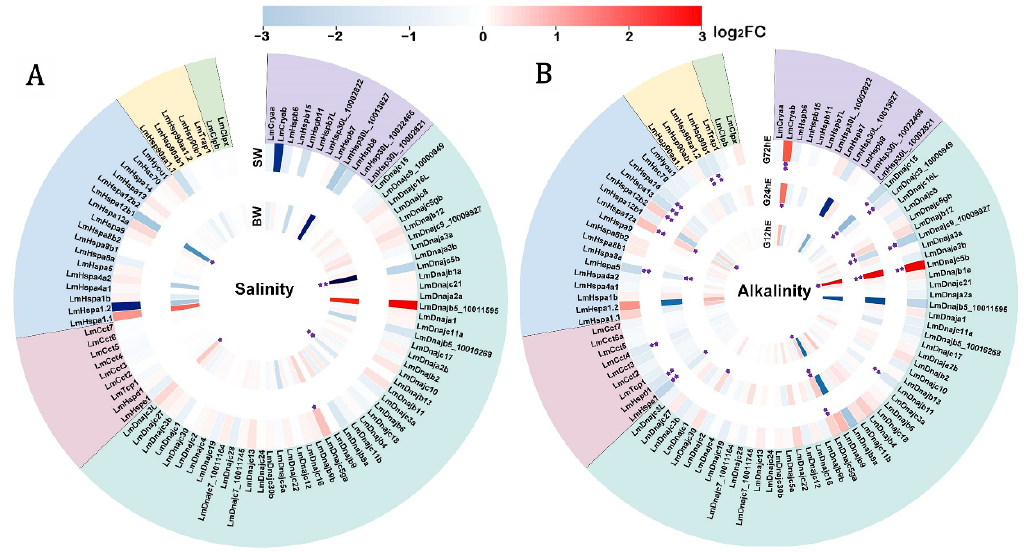
Figure 4. Regulated expression of LmHsp genes in gills of L. maculatus in response to ( A ) salinity change and ( B ) alkalinity stress. The heatmap was based on the log 2 FC values and ranked with each LmHsp family. BW and SW represent brackish and sew water groups compared to the freshwater group, while G12hE, G24hE, and G72hE indicate the alkalinity experiment duration for 12 h, 24 h, and 72 h, compared to the blank control 0 h, respectively. * indicates |log 2 FC| > 0.7 with p < 0.05, ** indicates |log 2 FC| > 0.7 with both p value and false discovery rate (FDR) < 0.05.